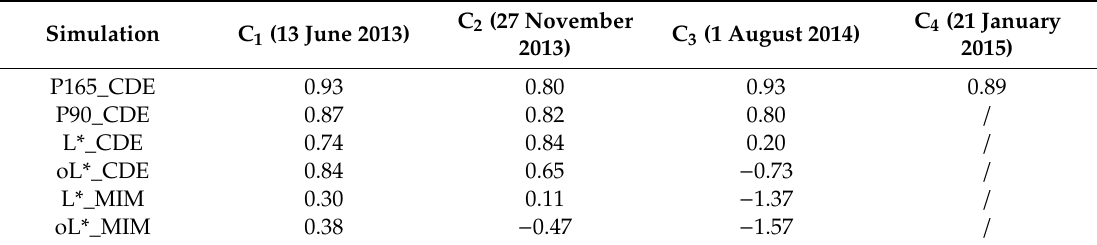
Note: P165 for results obtained with optimized parameters with HYDRUS-1D on the 165 cm deep profile; P90 for results obtained by applying the parameters optimized for the 165 cm deep profile to the 90 cm deep profile; L* for results obtained by applying the mean optimized parameters from the six lysimeters; oL*, the same as L* but for saturated water content values ( θ s * ) again optimized for each soil material. CDE for results obtained with the convection-dispersion equation. MIM for results obtained with the mobile-immobile model. Due to a lack of bromide in the 90 cm deep profile, e ffi ciency coe ffi cients were not calculated for the fourth monitoring